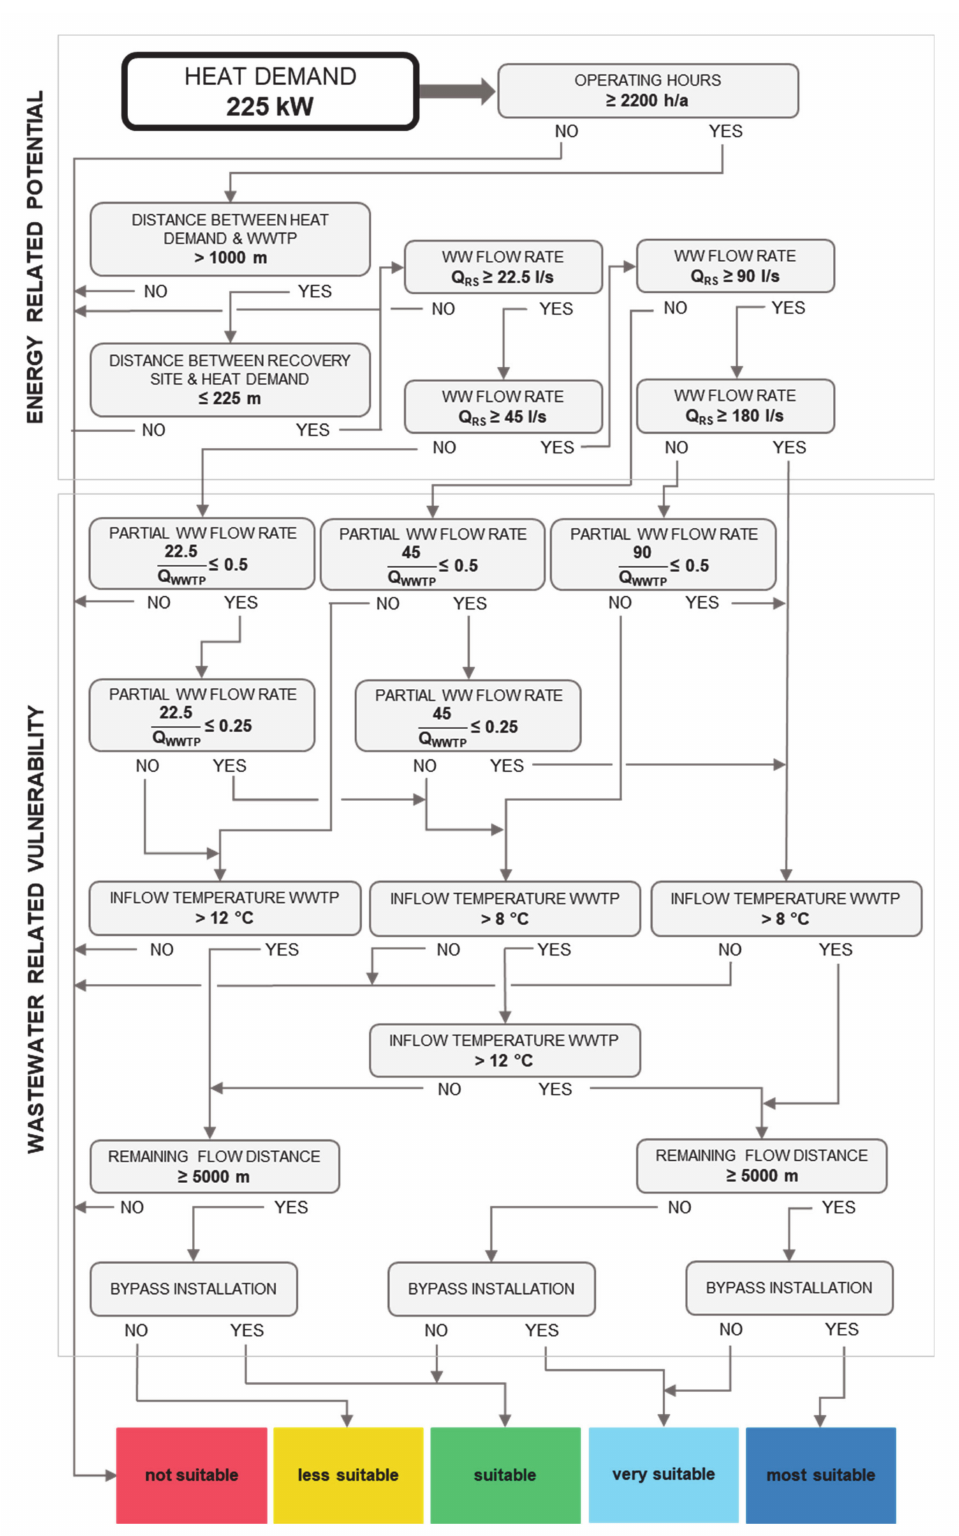
Figure A6. Relevance tree for an intended heat supply of 225 kW (own representation, based on